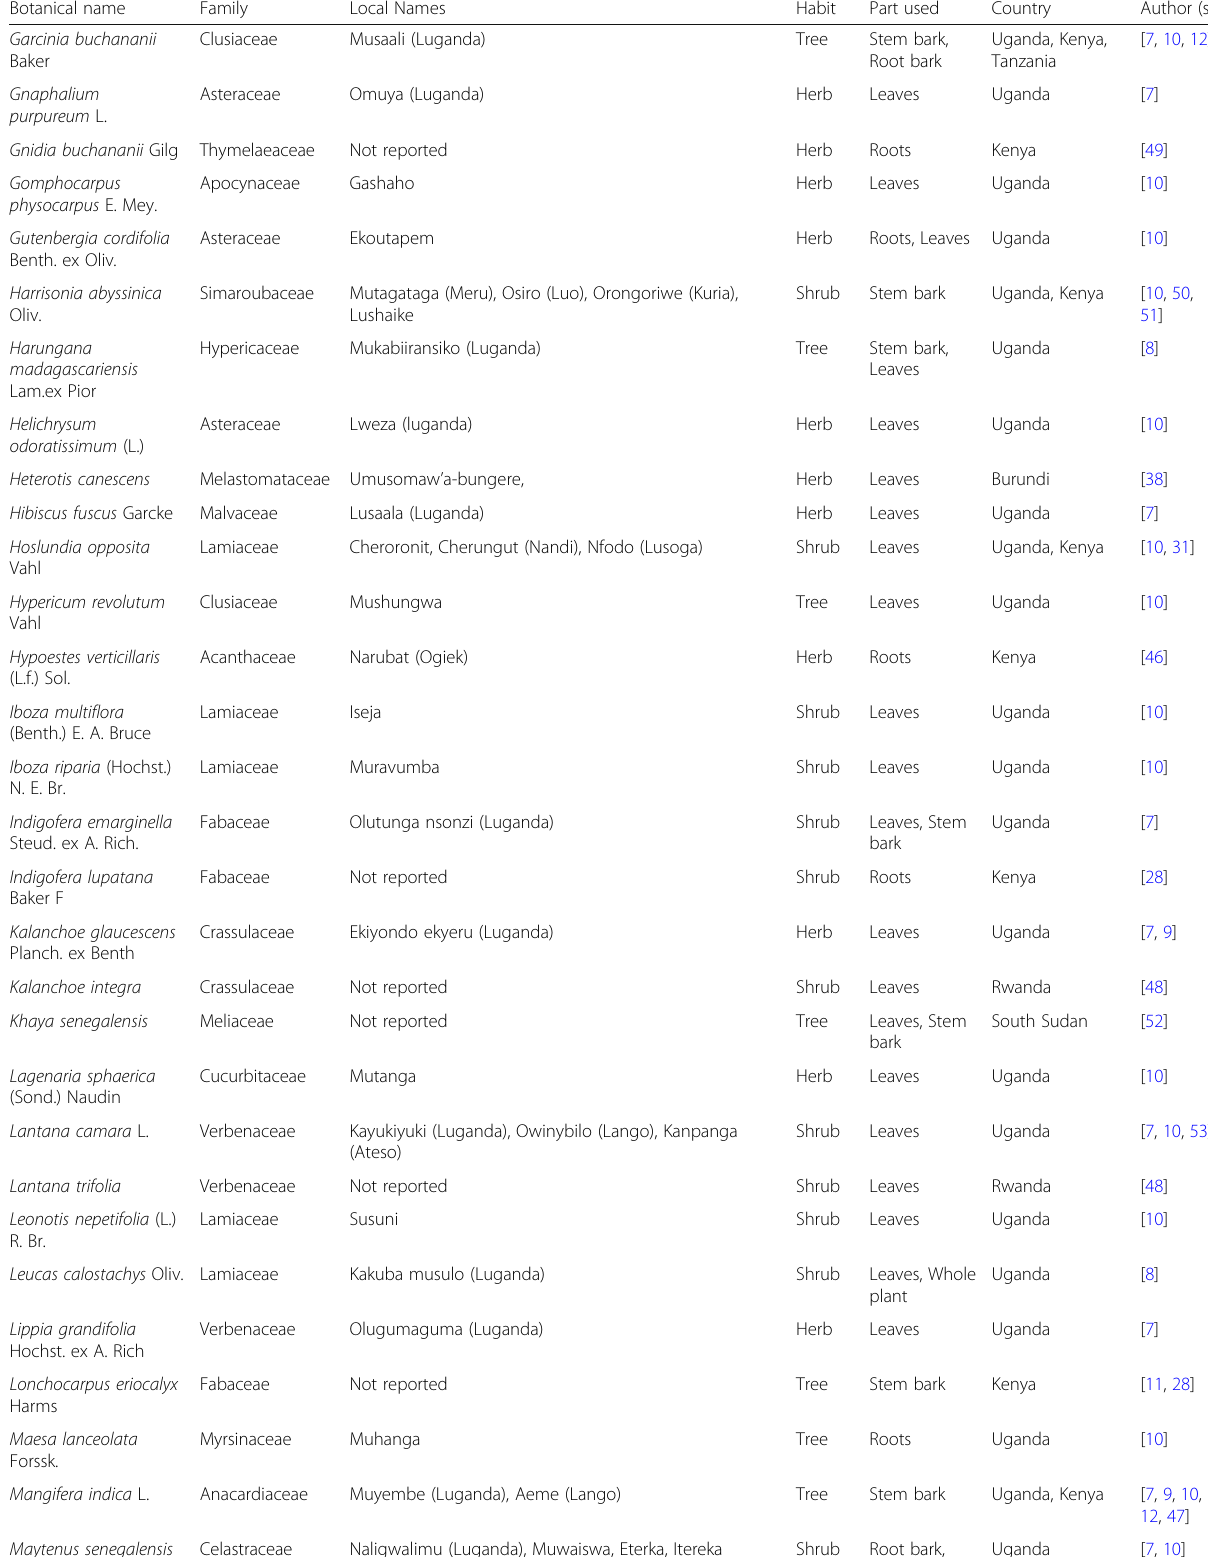
Table 1 Medicinal plants used in treatment of symptoms of TB in East Africa